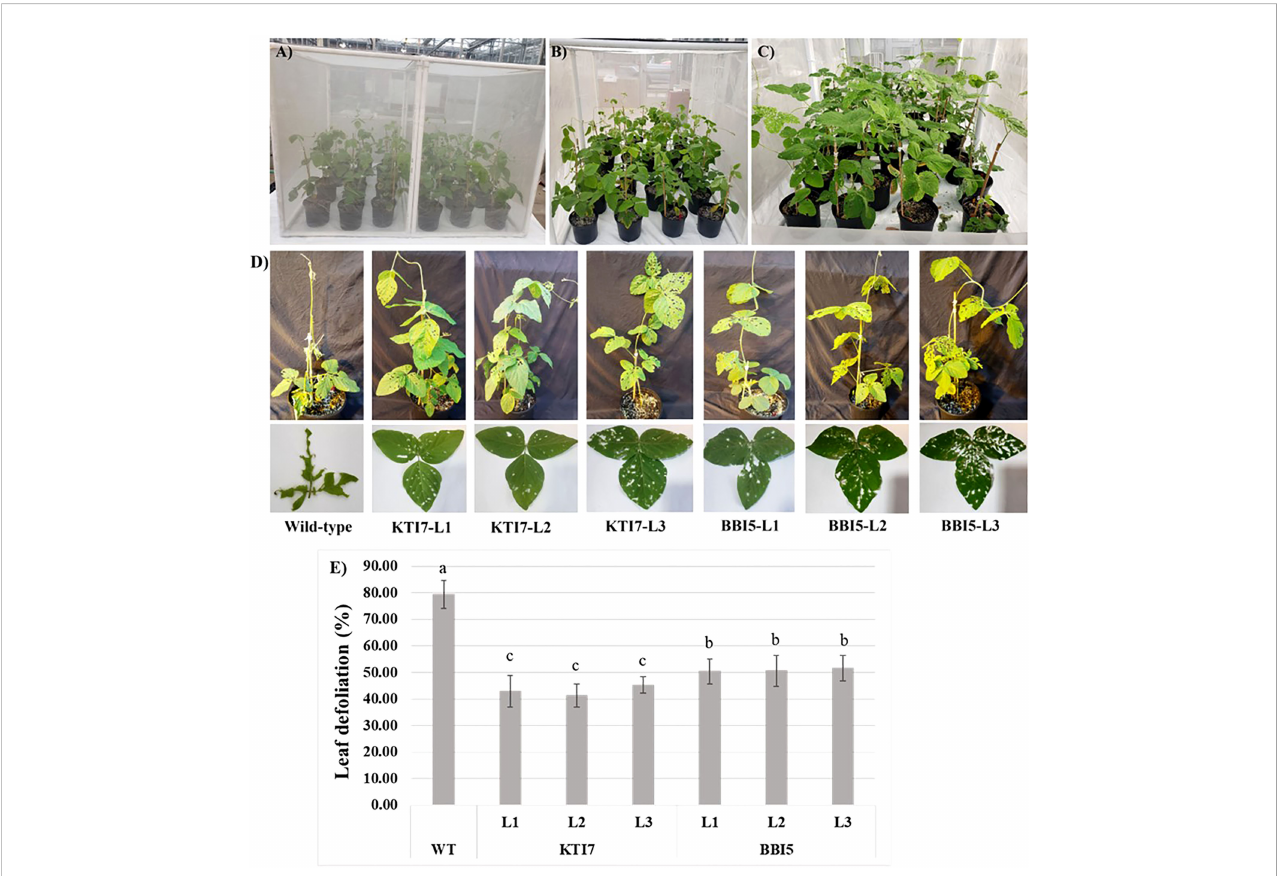
FIGURE 6 Whole plant feeding bioassay using six-week-old T 3 transgenic soybean plants that contain the 35S cauli fl ower mosaic virus promoter driving the expression of individual trypsin inhibitor genes (KTI7 and BBI5) grown under greenhouse conditions with corn earworm ( Helicoverpa zea ) second instar larvae. (A) Representative of transgenic and non-transgenic wild-type soybean plants in a polyester-mesh cage. (B) Ten larvae were added to each plant. (C) Ten days after larvae feeding. (D) Representative defoliated wild-type and transgenic plants. (E) Leaf defoliation rate after 10 days of larvae feeding of wild-type (WT) and transgenic lines. Bars represent mean values of six biological replicates (plants) per each independent line (L1, L2, L3) ± standard error. Bars with different letters are signi fi cantly different at p < 0.05 as tested by one-way analysis of variance followed by a Fisher ’ s least signi fi cant